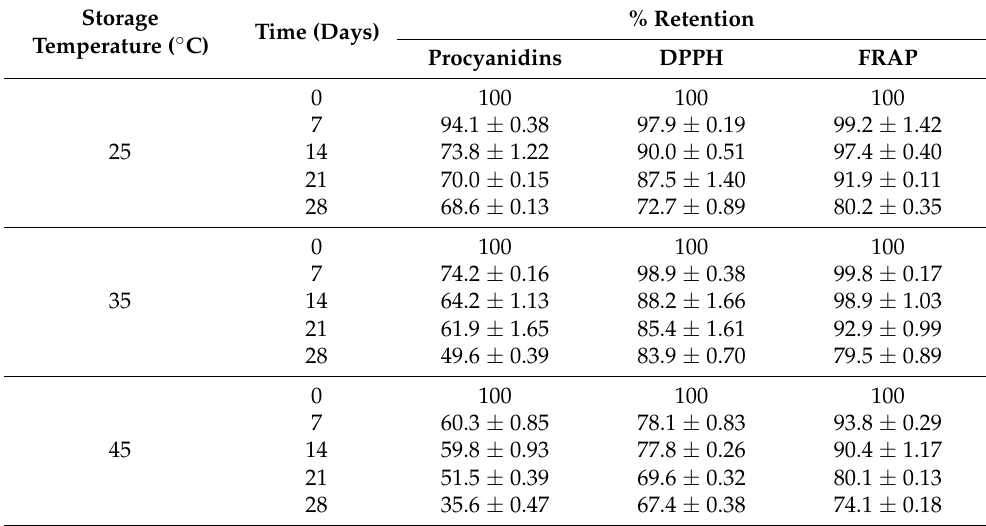
Table 5. Effect of storage temperature and time on the retention percentage of procyanidins and antioxidant activities of DPPH and FRAP in dry GSS extract